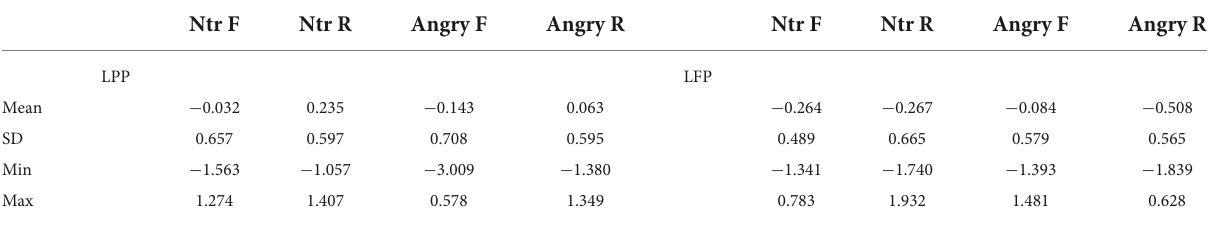
TABLE 3 Means and standard deviations for LPP (late parietal positivity) and LFP (late frontal positivity) ERPs elicited by cues following neutral (ntr) or angry faces.